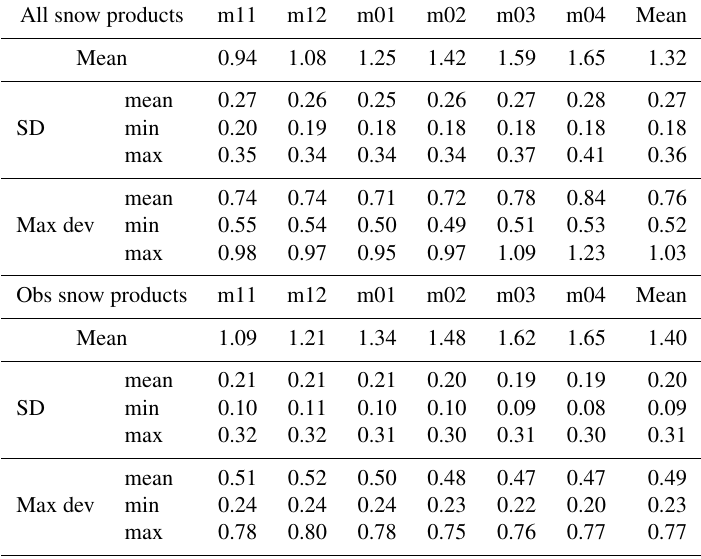
Table A3. Statistical impact of the various snow depths on SIT in the Arctic over the 2013–2019 time period. The upper part considers all the snow depth products while the upper part consider only the products based on observations (ASD, DuST, AMSR2B and W99m). Note that AMSR2B SIT estimations on MYI are only taken into account for the months of March and April.